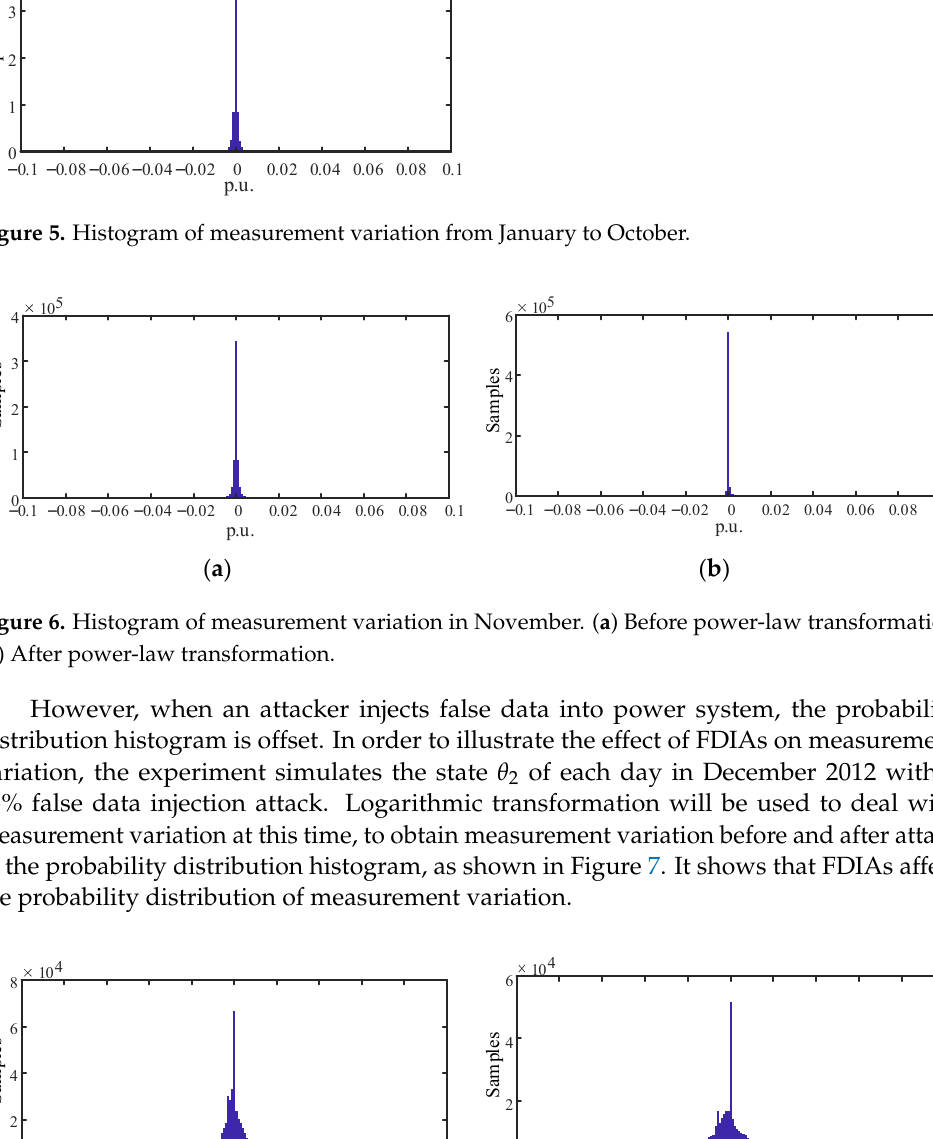
Figure 5. Histogram of measurement variation from January to October.